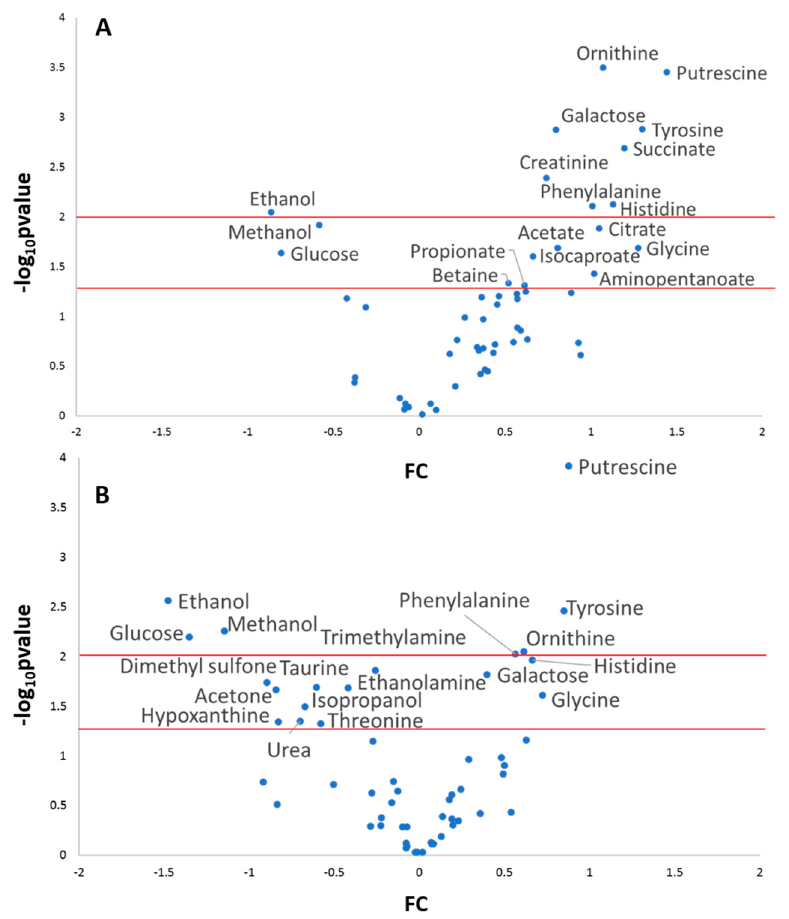
Figure 6. Volcano plots of changes in salivary metabolome for the game group (n = 7) using data normalized using TPWS ( A ) and TOMC ( B ). Red lines indicate the two threshold of significance ( p = 0.01 and p = 0.05). The fold change, FC, was calculated as log 2 [post]/[pre].